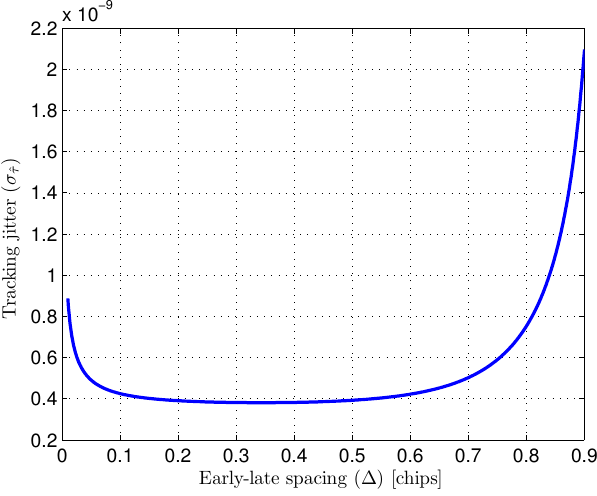
) caused by AWGN as a function of early-late ˆ τ